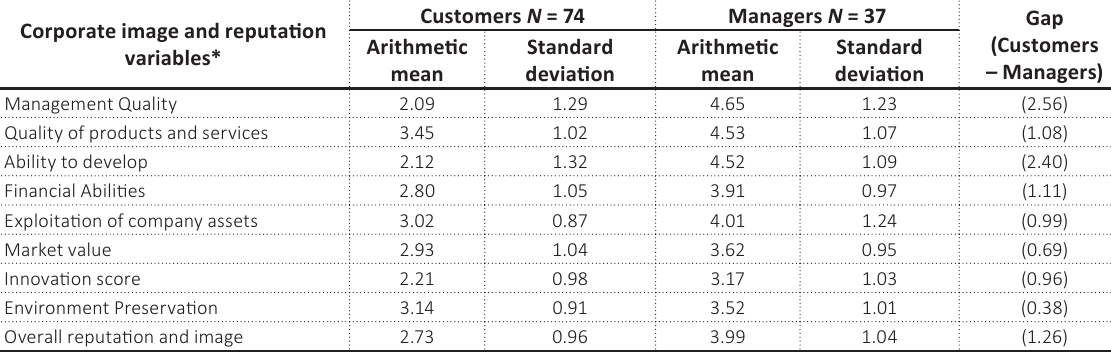
Table 1. Survey results on measuring sample companies’ reputation and image